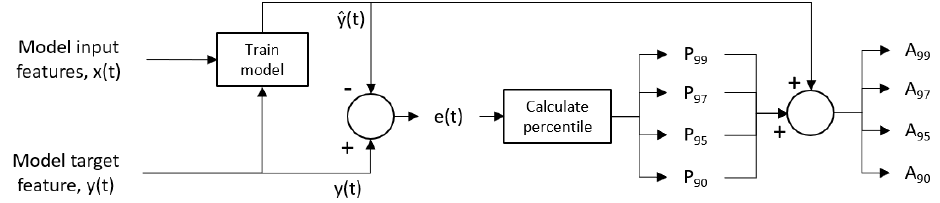
Figure 6. Process for creating alarm level through NBM, adapted from